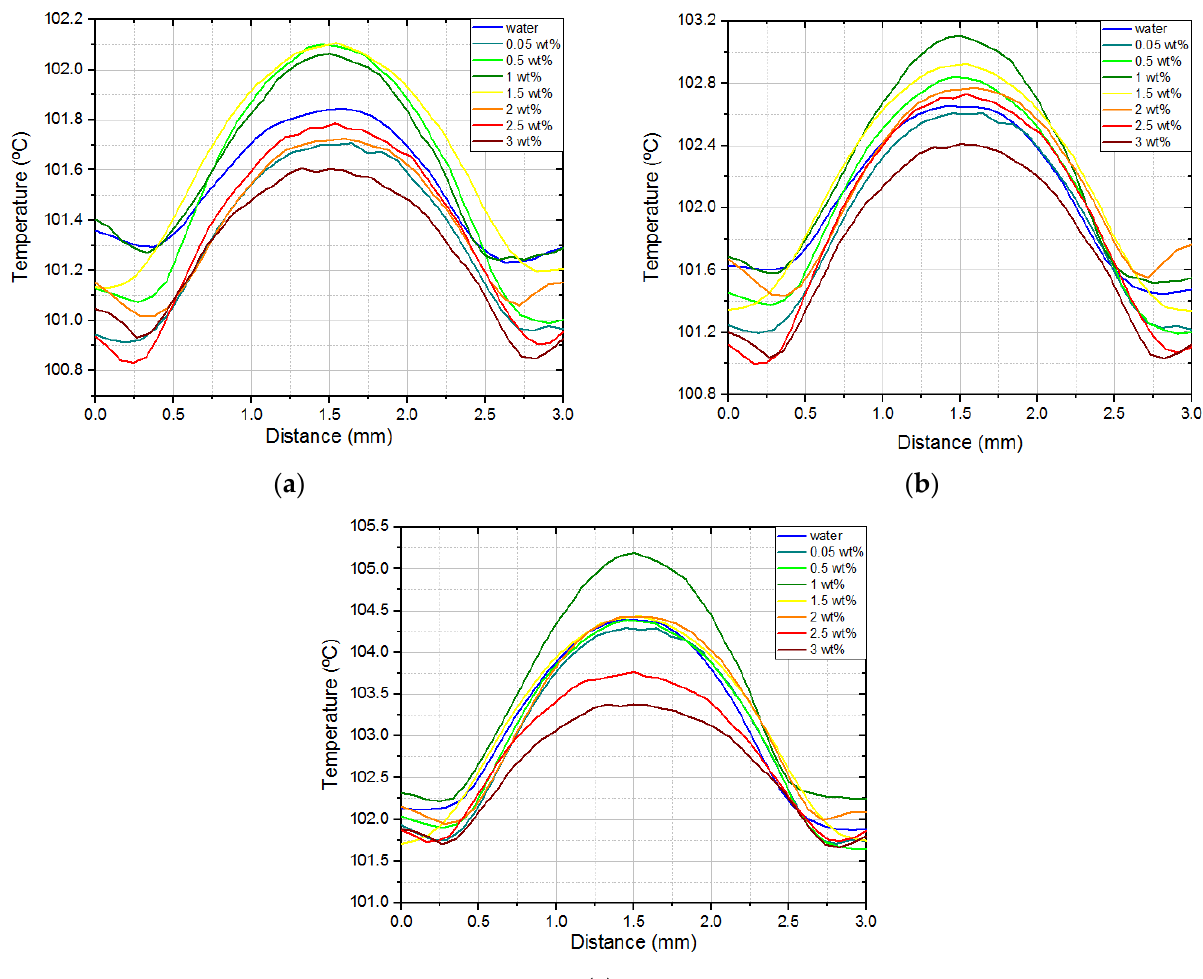
Figure 5. Mean surface temperature profiles for all working fluids. The superhydrophobic region is 1.5 mm diameter. The imposed heat fluxes are: ( a ) 1290 W/m 2 (7 A), ( b ) 2132 W/m 2 (9 A), and ( c ) 3790 W/m 2 (12 A).